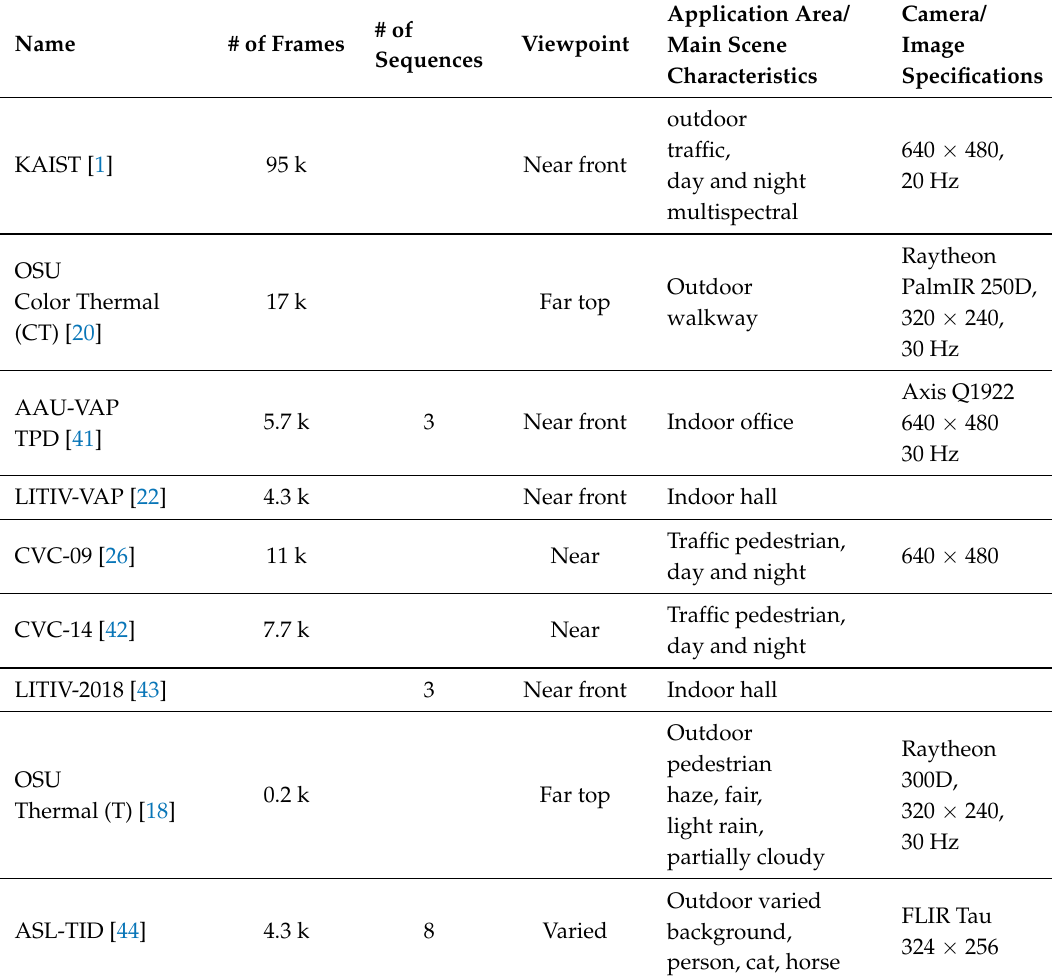
Table 1. Available thermal datasets for person detection and the characteristics of each dataset. “Application area/main scene characteristics” summarizes the main features of the videos in each dataset. “Viewpoint” is estimated by generally looking at the image for the camera angle and the distance of persons from the